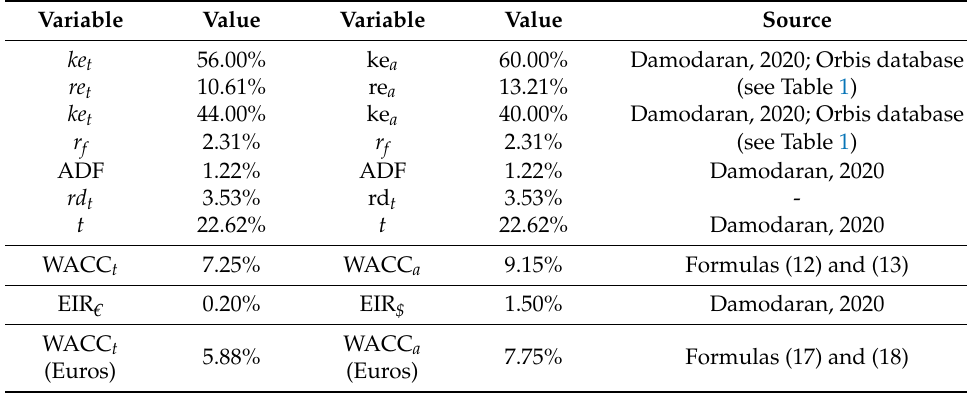
Table 2. WACC t and WACC a for